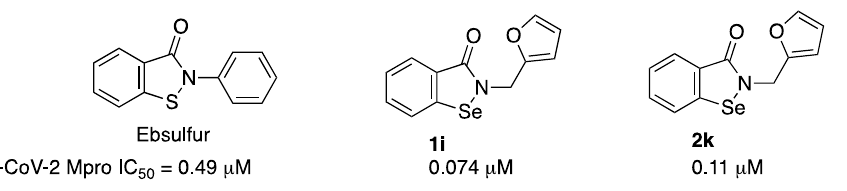
Figure 10. Ebsulfur and ebselen derivatives.